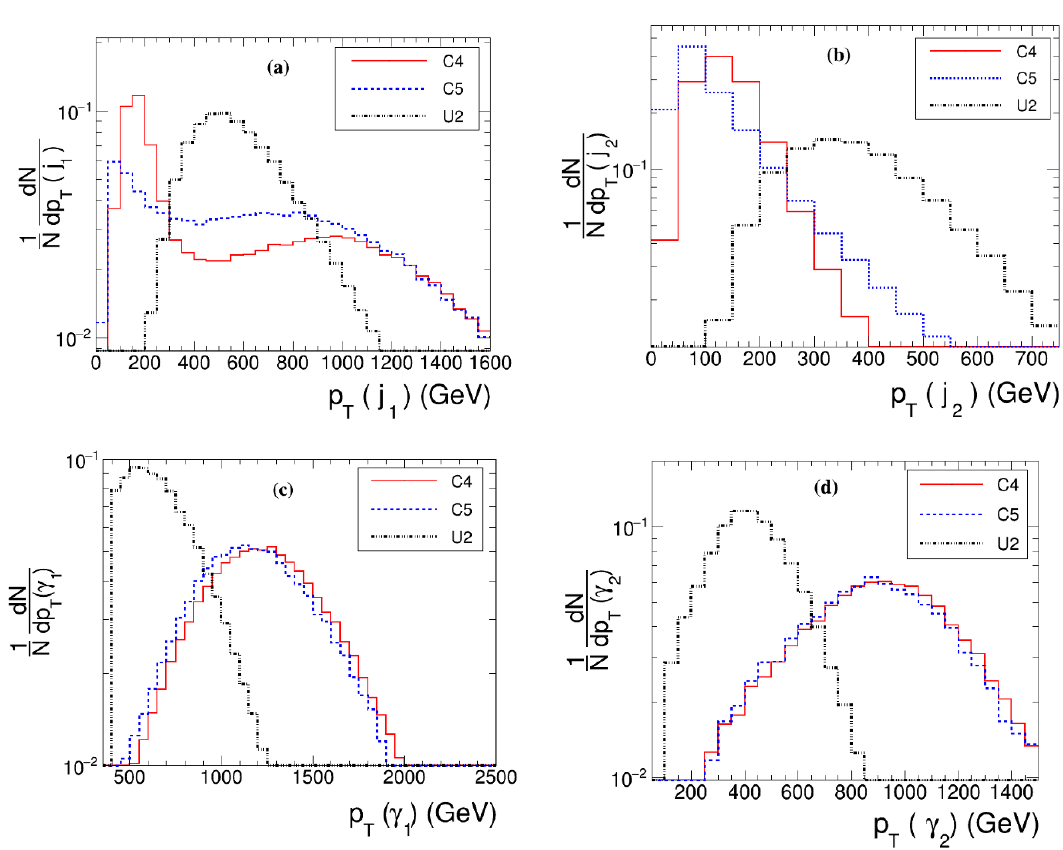
Figure 5 . The leading and subleading jet and photon p T distributions for some of the benchmark points representing various compressed ( C4 ), more compressed ( C5 ) and uncompressed ( U2 ) spec- tra after implementing the selection and analysis cuts A0 { A6